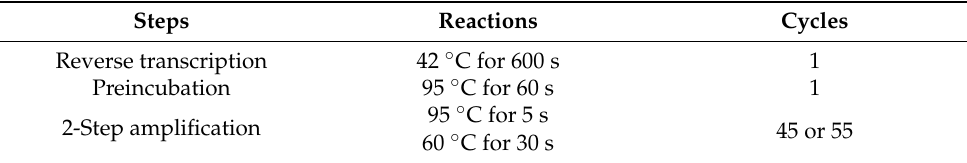
Table 1. Reverse transcription and real-time PCR